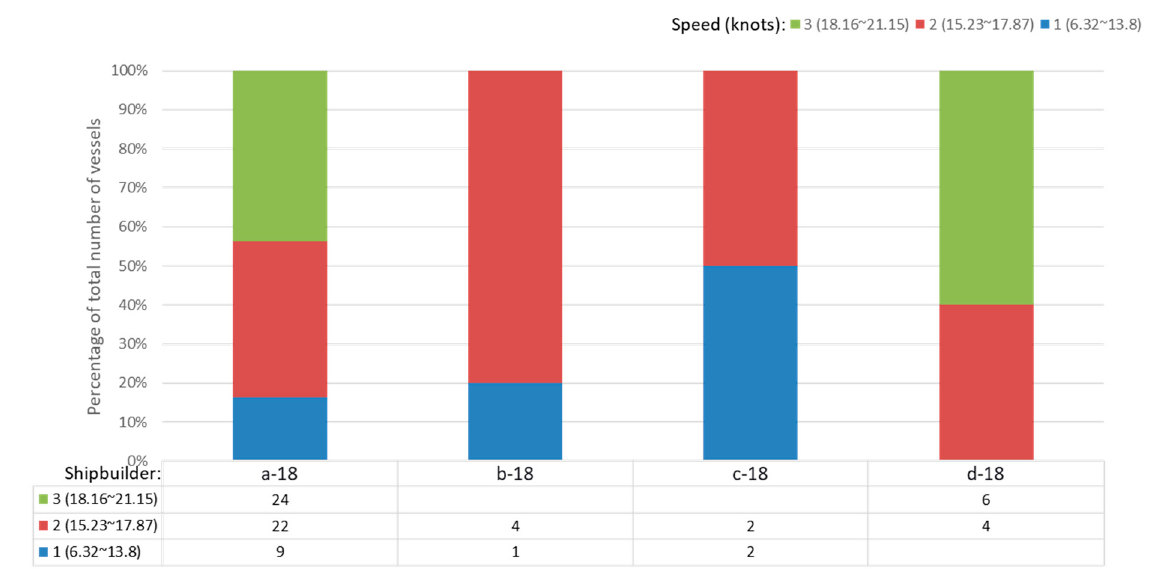
Figure 17. Speed clustering result of the 18,000 TEU container ships by shipbuilders.